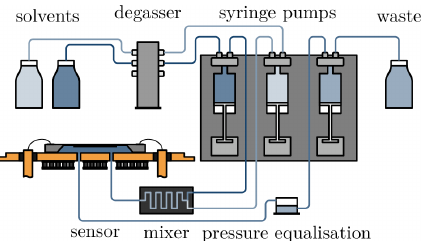
Figure 2. The fluidic setup. To mix an analyte at a specific con- centration, the volume flow ratio of two syringes is controlled. The degasser is used to prevent pressure fluctuations caused by air bub- bles in the liquid. The sensor itself is mounted on a Peltier element to control